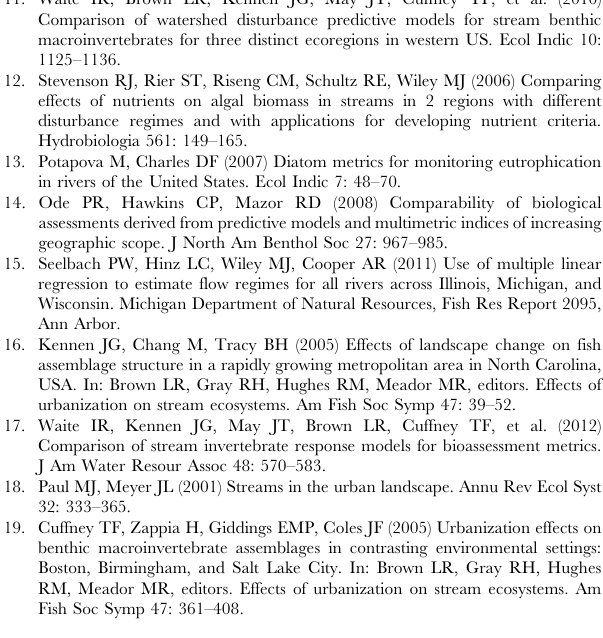
Figure S1 Partial dependency plots for variables in BRT model for the other three invertebrate metrics for all the Regions. Boosted regression tree partial dependency plots show the response form for invertebrate metrics (y-axis = fitted function of invertebrate metric) based on the effect of individual explanatory variables with the response of all other variables removed (development data set); variables shown in order of